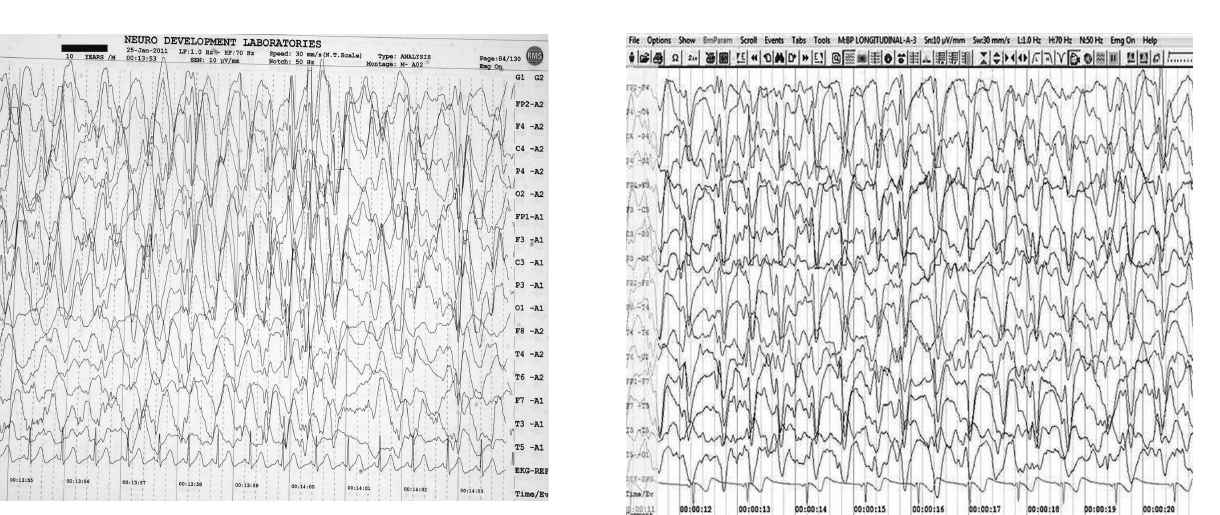
Figure 3: Scalp electroencephalogram showing 1-2 Hz generalized synchronous spike-wave discharges occupying more than 80% of tracing, consistent with nonconvulsive status epilepticus (Case